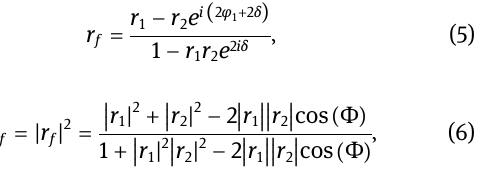
possess nearly the same magnitudes ( | χ opposite phases across the high-re fl ectance angles. The completely destructive interference leads to near 100% re fl ectivity and maintains in wide-angle regime, generating a broad and high re fl ectance spectrum.